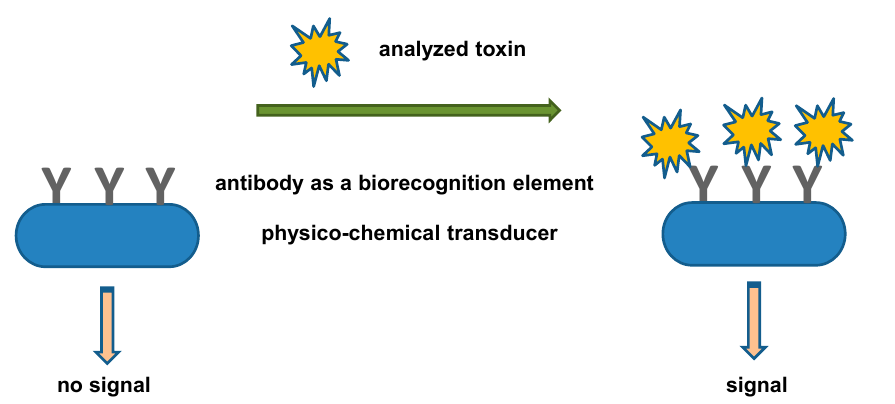
Figure 1. General principle of an immunosensor for toxin assay.